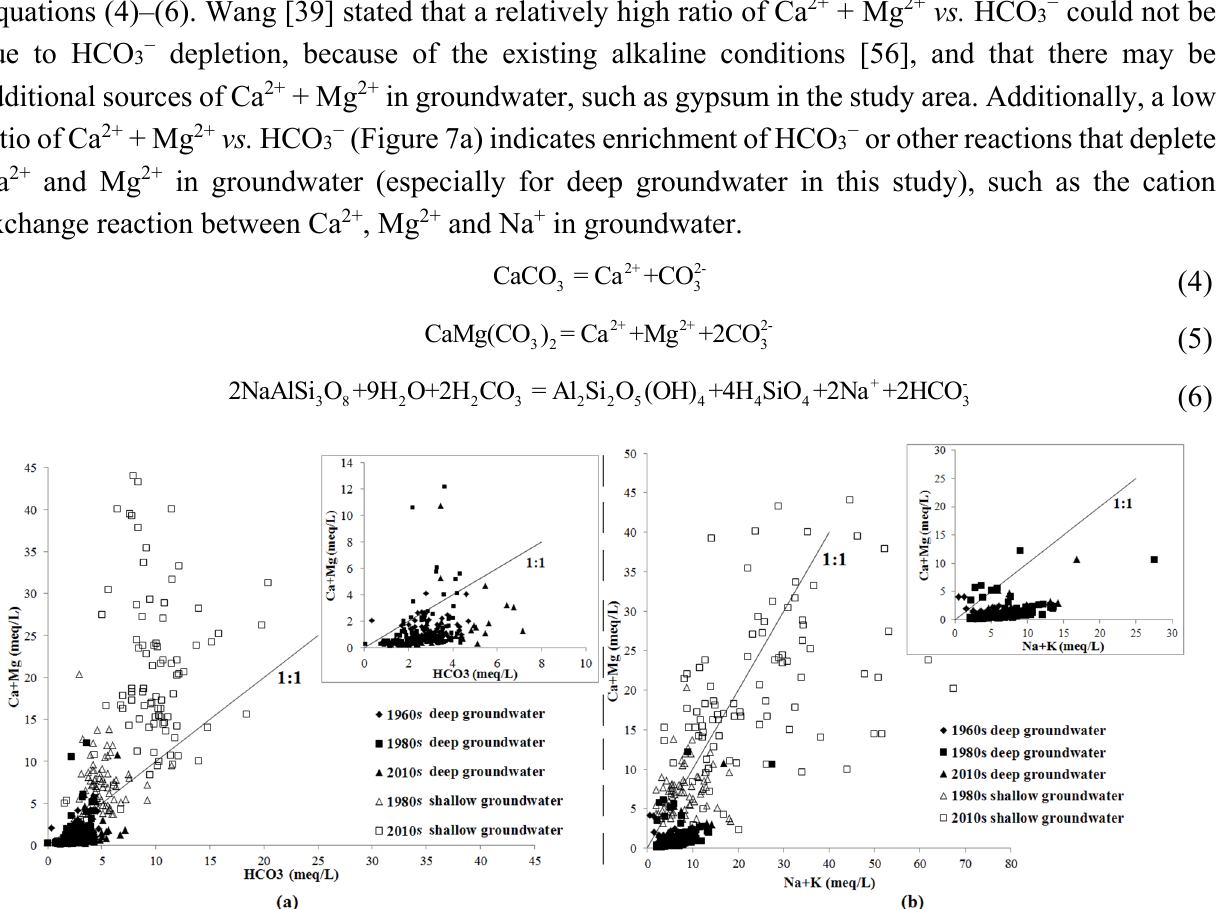
Figure 7. Scatter plots of Ca 2+ + Mg 2+ vs. HCO 3 − ( a ) and Ca 2+ + Mg 2+ vs. Na + + K + ( b ) of groundwater samples in